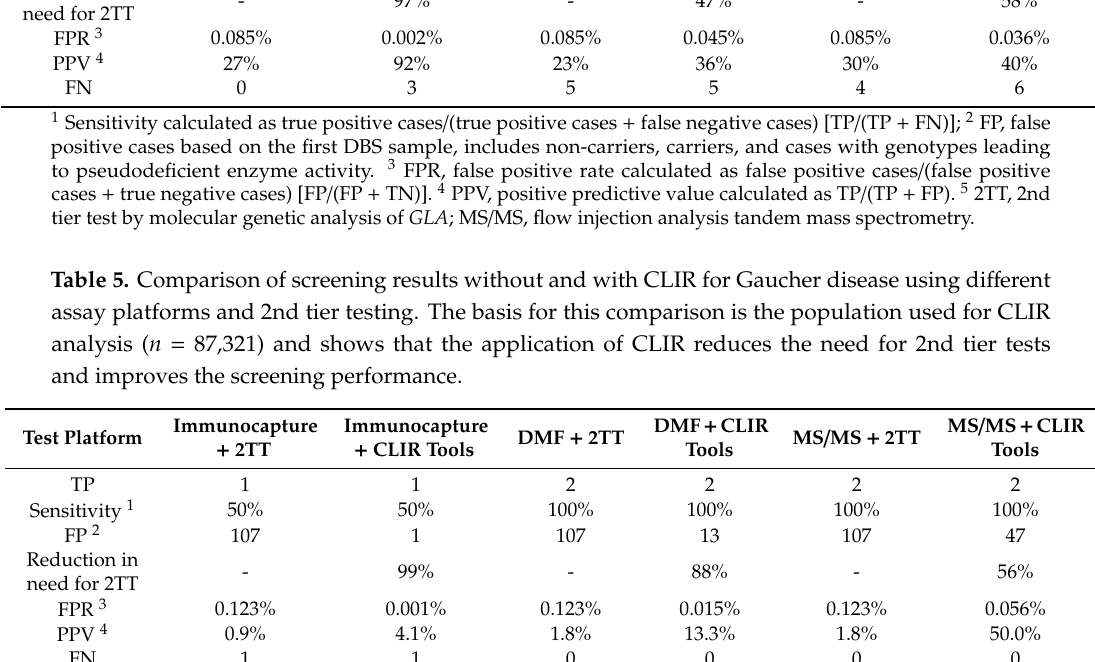
1 Sensitivity calculated as true positive cases / (true positive cases + false negative cases) [TP / (TP + FN)]; 2 FP, false positive cases based on the first DBS sample, includes non-carriers, carriers, and cases with genotypes leading to pseudodeficient enzyme activity. 3 FPR, false positive rate calculated as false positive cases / (false positive cases + true negative cases) [FP / (FP + TN)]. 4 PPV, positive predictive value calculated as TP / (TP + FP). 2TT, 2nd